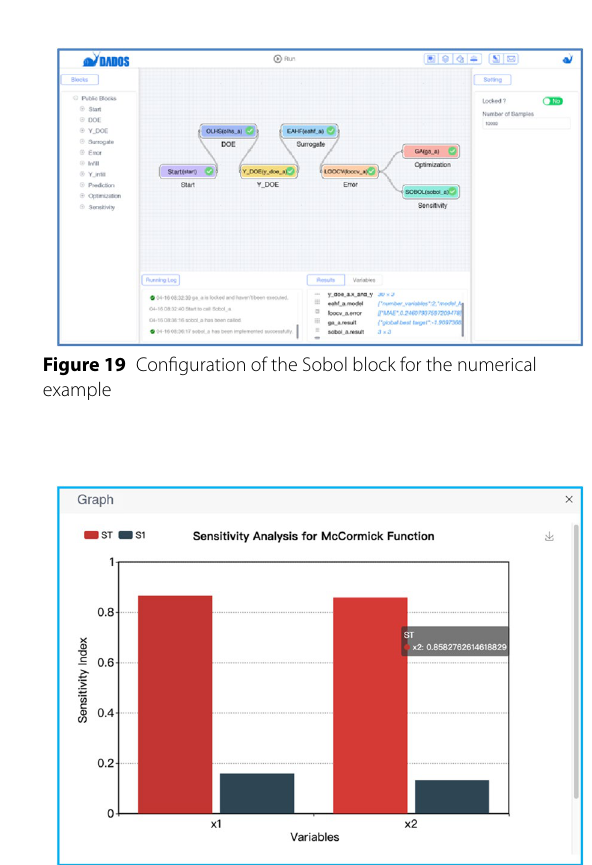
Figure 20 The first-order index and total order